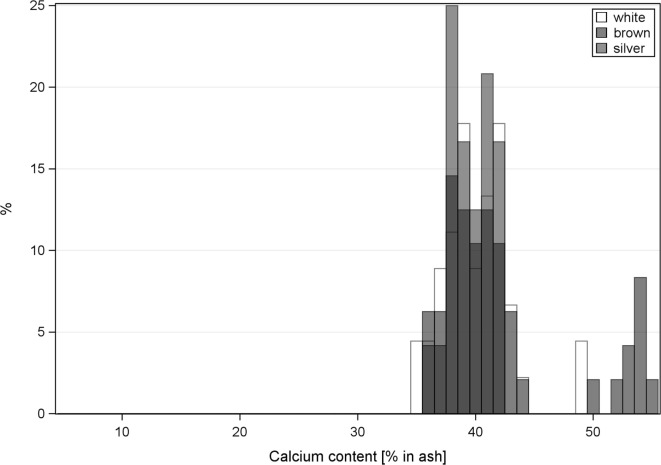
Histogram of the calcium content of keel bones (a) and tibia (b). White hens have white bars, brown hens have black bars, and silver hens have gray bars.